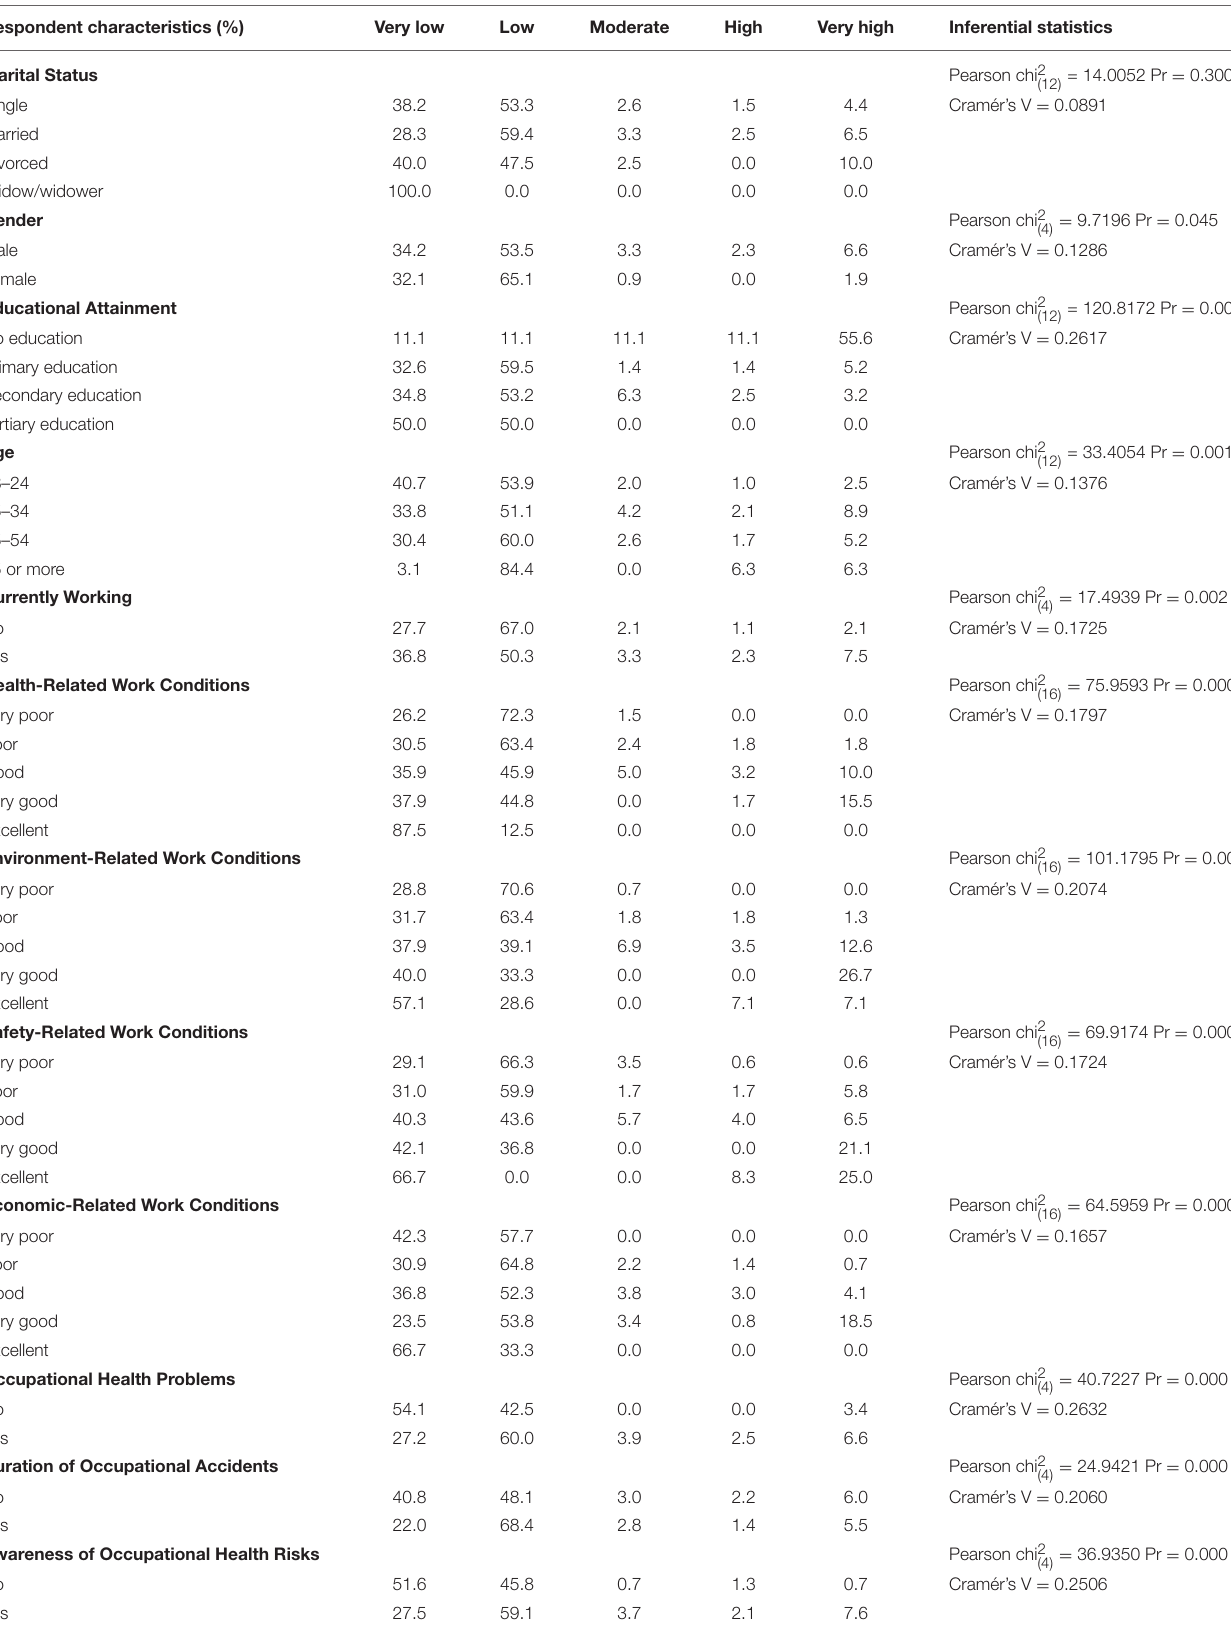
TABLE 2 | Levels of artisanal miners’ knowledge of Environmental and Health Effects of Hg ( n = 588 ). Respondent characteristics (%) Very low Low Moderate High Very high Inferential